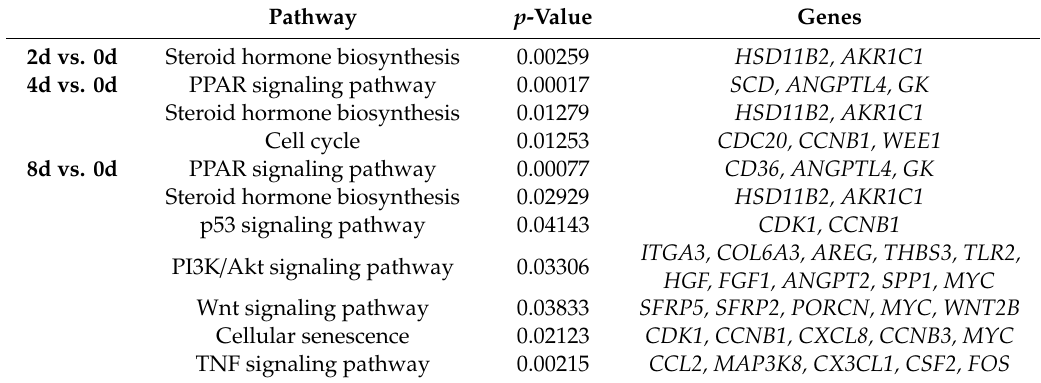
Table 4. Summary of Kyoto Encyclopedia of Genes and Genomes (KEGG) enrichment analysis of DEGs (only significant pathways